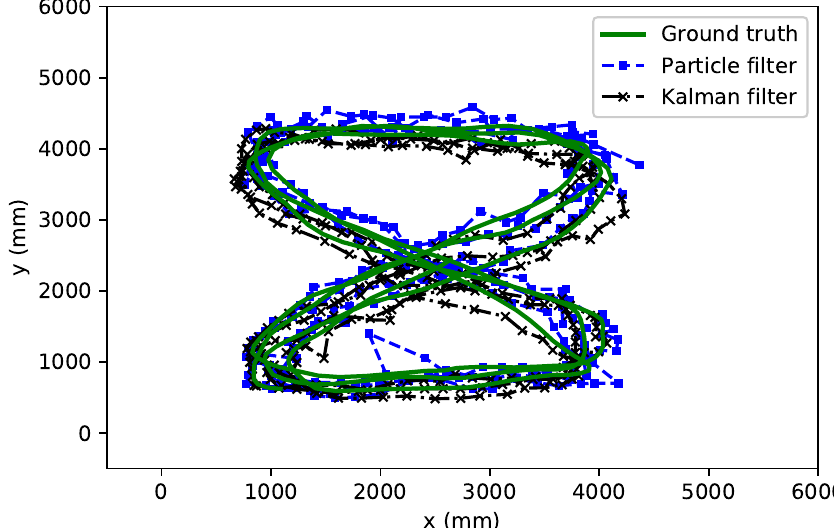
Figure 9. Position computed with particle filter (dashed line with square marker), with the Kalman filter (dashed line with cross marker), and with ground truth (solid line) for an eight-shaped path.